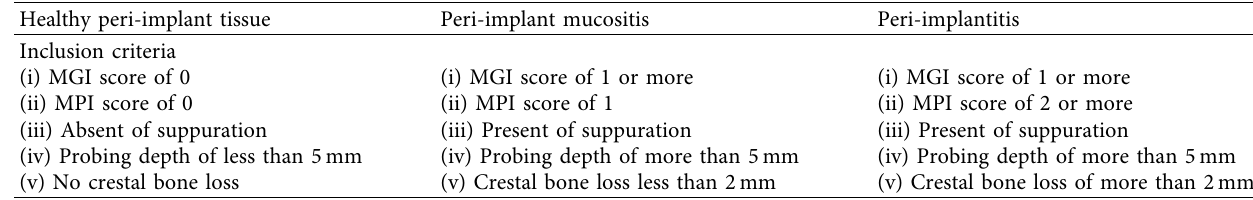
Table 1: Clinical and radiographic parameters for healthy and diseased peri-implant tissue. Healthy peri-implant tissue Peri-implant mucositis Peri-implantitis Inclusion